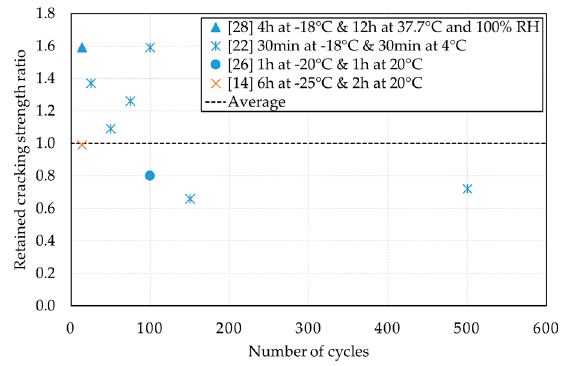
Figure 2. Effect of freeze–thaw cycles on the matrix tensile strength (blue marker = cement-based matrix, orange marker = lime-based matrix).